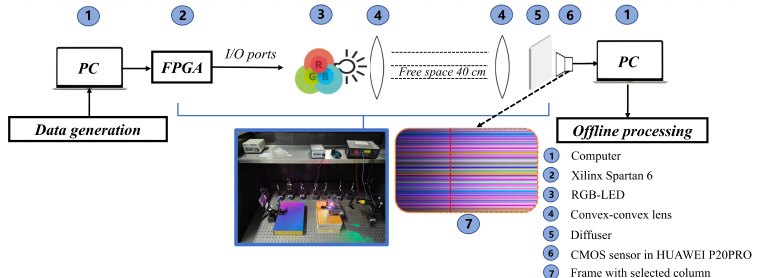
Figure 11. Block diagram and scene of the experimental setup. CMOS-based camera in HUAWEI P20PRO is the receiver and single RGB-LED drived by I/O ports of FPGA is the